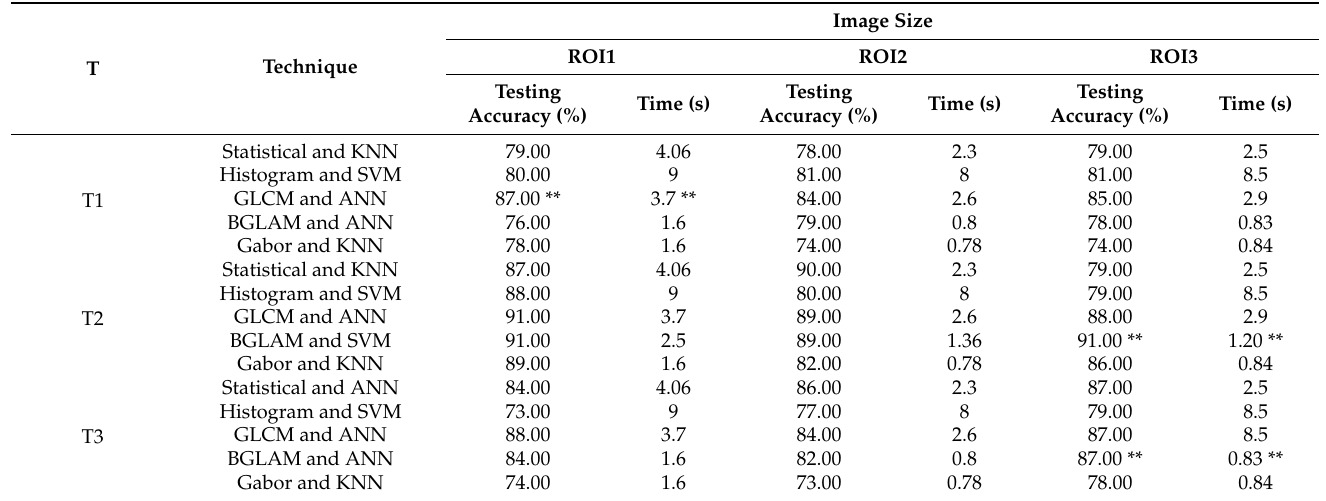
Table 8. Results of test computing FFB ripeness classification with statistical, histogram, GLCM, BGLAM and Gabor using ANN, KNN and